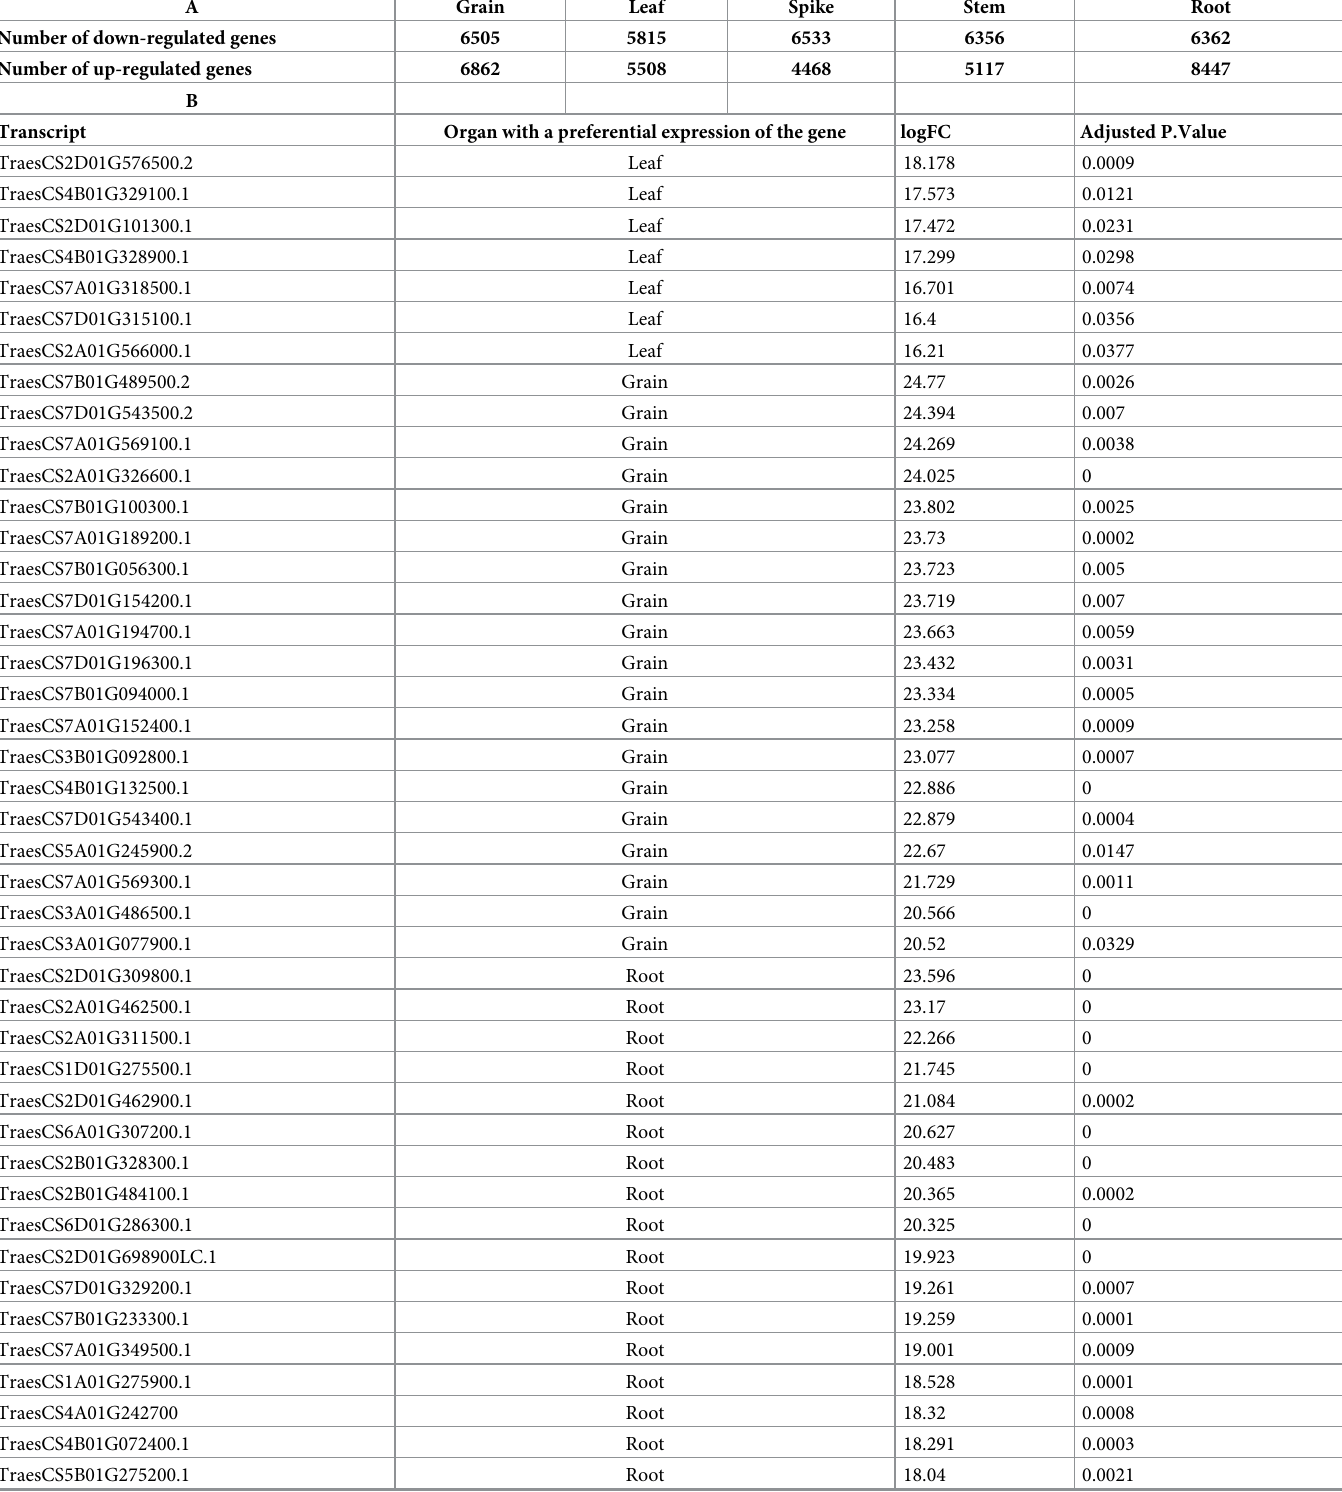
Table 2. Number of differentially expressed genes (A) and list of preferentially expressed TaNAC genes (B) in five wheat